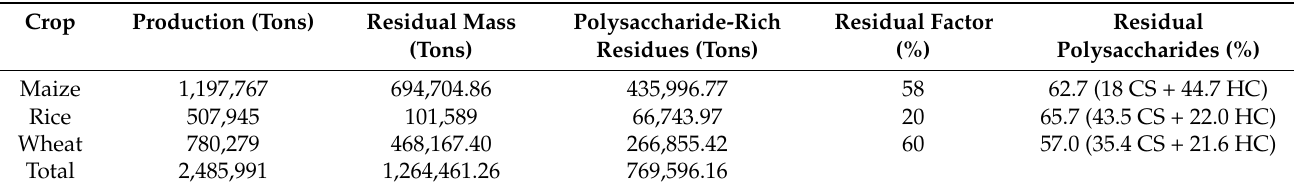
Table 2. Biomass, estimative residual mass, percentage factor, and polysaccharides content of three major cereal crops in 2021.